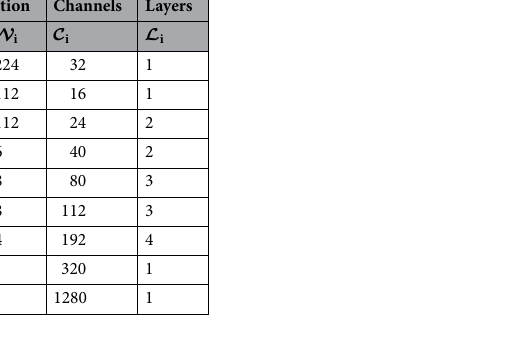
Table 2. The EfficientNet-B0 layer 5